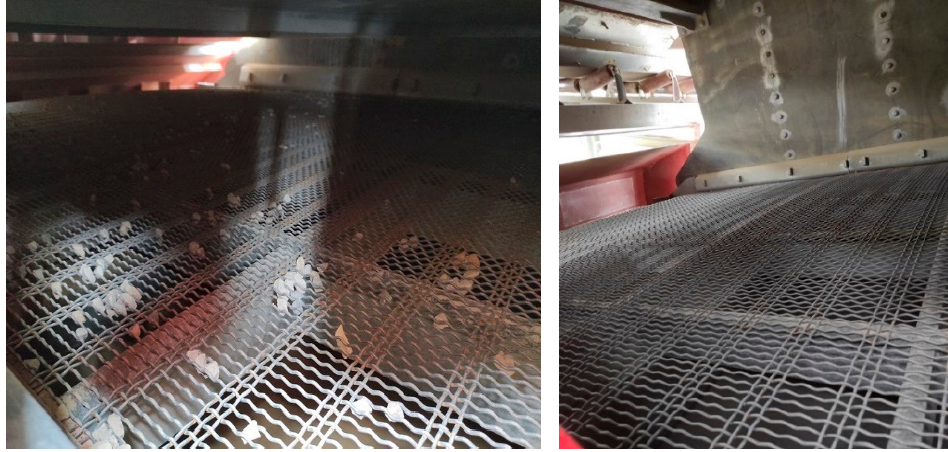
Figure 12. Photographs showing the condition of sieve blockage with difficult grains: At a toss index of 5.5 ( left ), at a toss index of 6.6 ( right ).